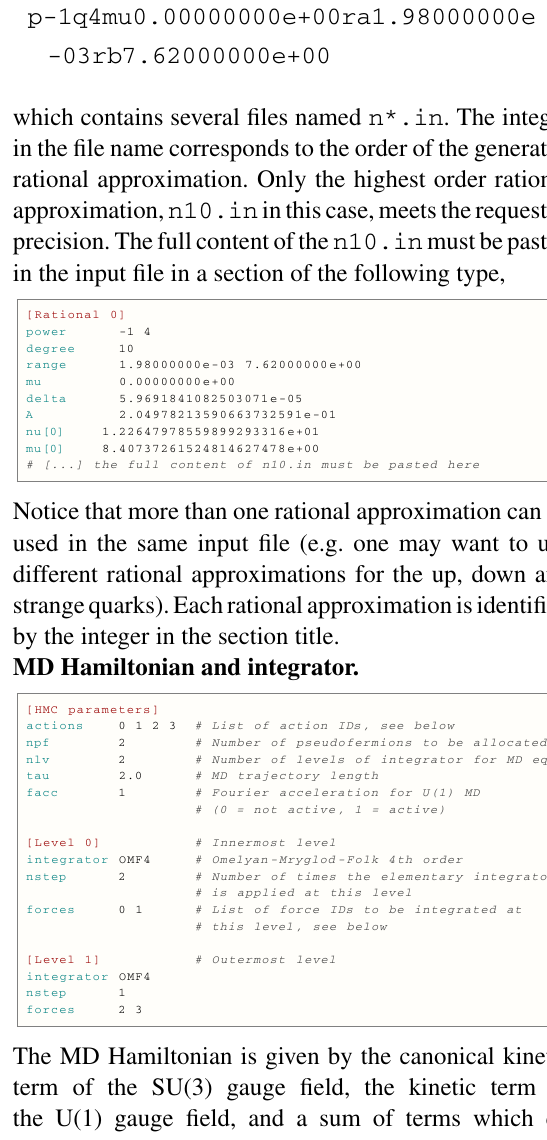
Refer to doc/fourier.pdf and Sect. 2 for